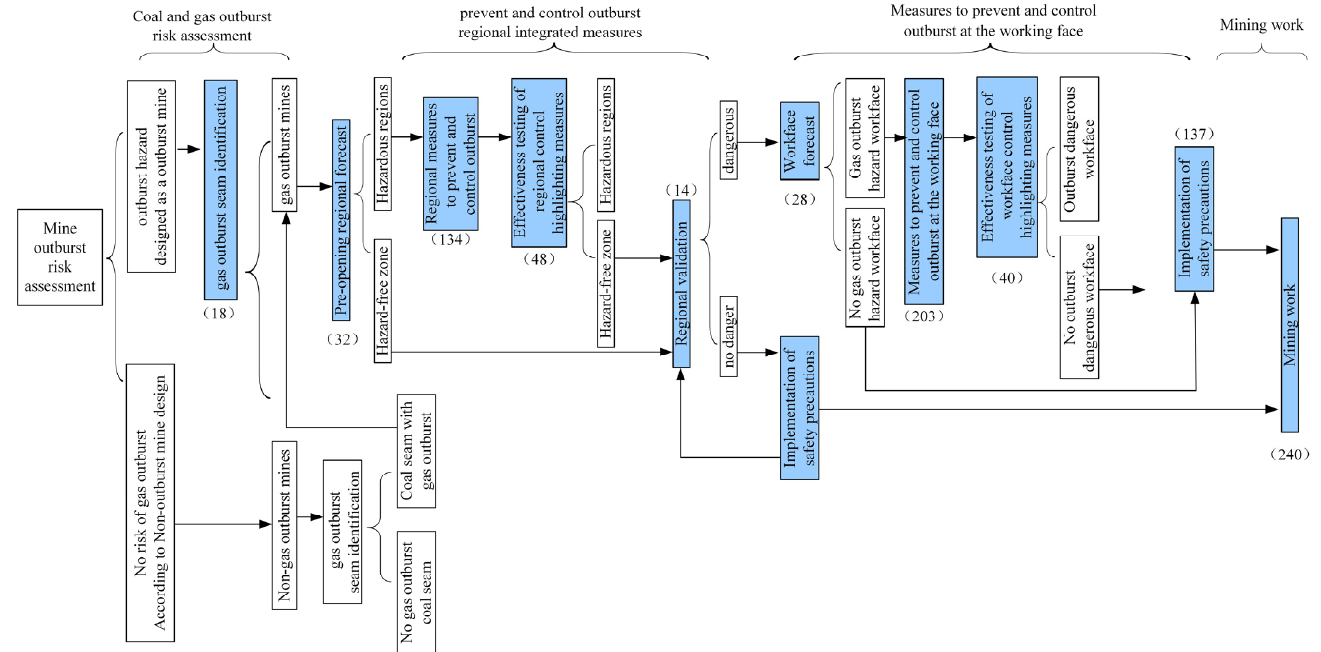
Figure 4. Prevention and control process of coal and gas outburst. Table 3. Summary of unsafe behaviors for gas outburst accidents.